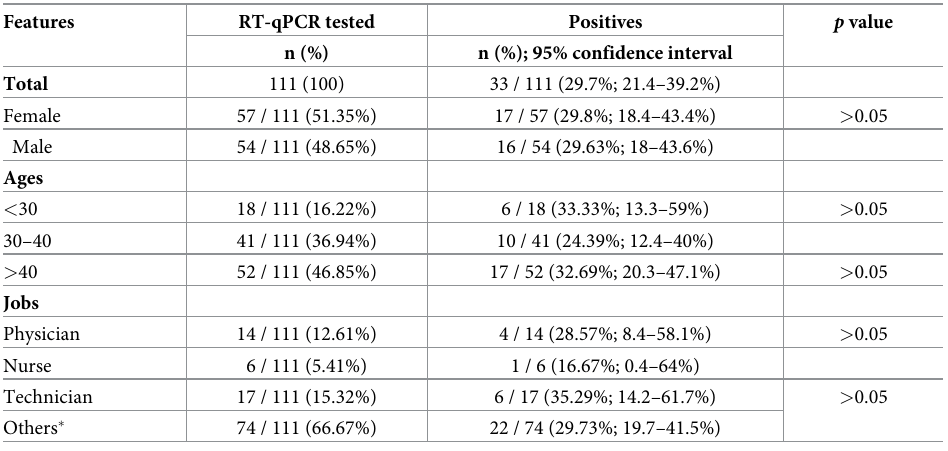
All results associated with the RT-qPCR analysis are detailed in Table 3. From the 176 volun- teers that donated blood for the antibody study, 111 were also swabbed for PCR. Of those 111, Table 3. RT-qPCR results of tested voluntarily HCWs according to gender, age groups, and jobs.